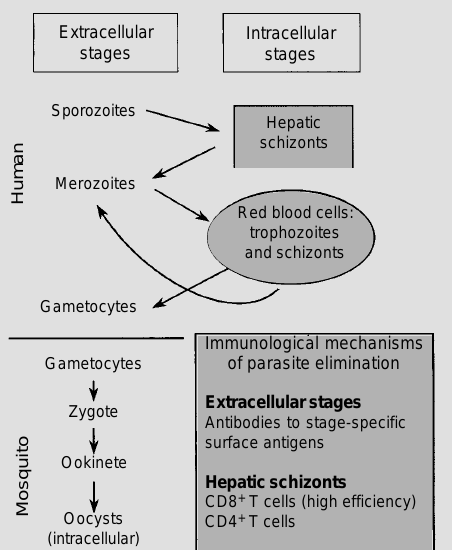
2 - Schematic representa- tion of multiple antigen peptide